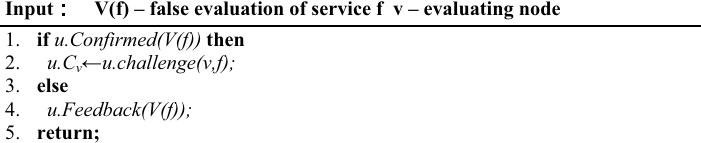
Algorithm 4: u.FeedbackProcess(V(f),